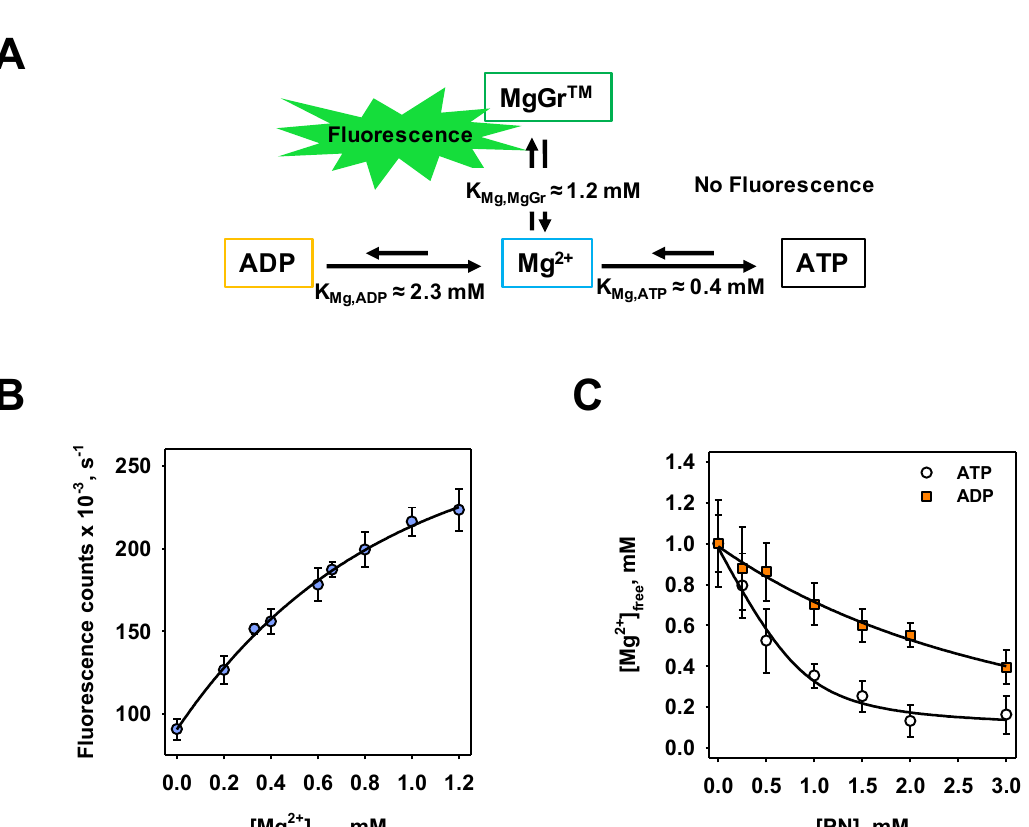
Figure 1. Working principles for ADP/ATP exchange measurements using MgGr TM fluorescent dye. ( A ) A schema demonstrating the principle of the method. Mg 2+ binds to MgGr TM , ATP and ADP with different affinities that results to the formation of fluorescent (Mg-MgGr TM ) or non-fluorescent (Mg- ATP) complexes. ( B ) Dependence of fluorescence intensity of MgGr TM on Mg 2+ concentration. The line